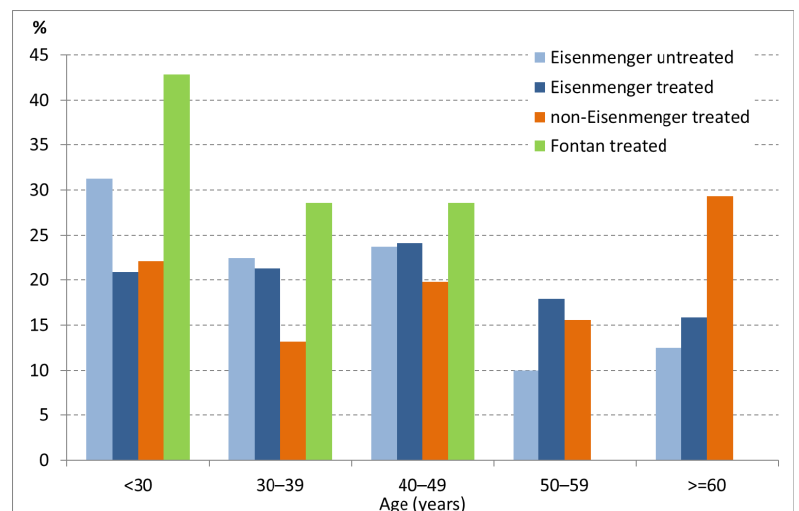
Figure 1. Age distribution of the population with CHD-associated pulmonary arterial hypertension (PAH). Data represent the percentage of patients from each subgroup in the respective age groups. CHD, congenital heart disease.